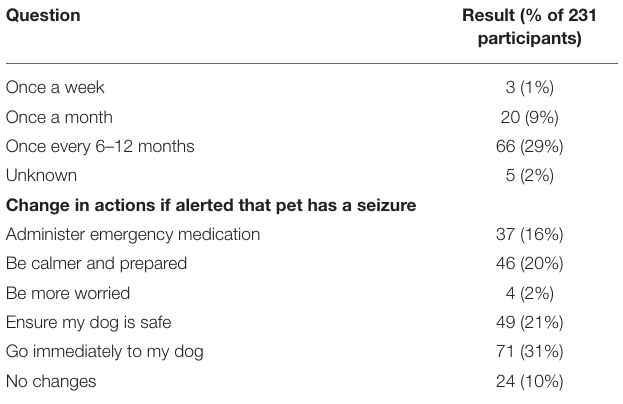
TABLE 1 | Survey results—part